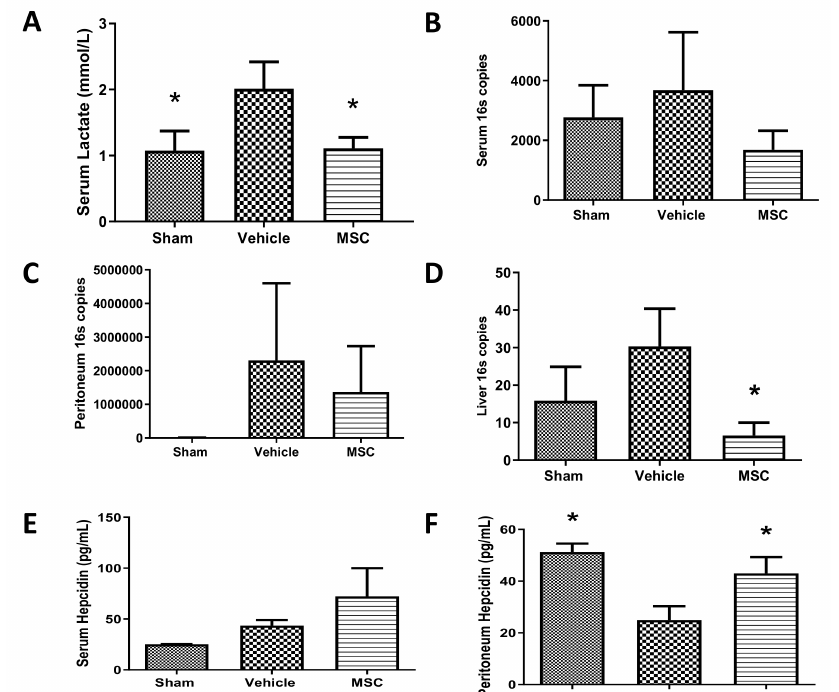
Figure 3. Reduced serum lactate and bacterial genome number and increased antimicrobial peptide after CD362 + UC-MSC administration at 4 h. Administration of CD362 + UC-MSCs 4 h after CLP induction reduced the lactate measured in serum 48 h after the CLP procedure compared with vehicle ( A ). Reduction of copies of the 16S fraction of the bacterial genome in serum after CD362 + UC-MSC administration. ( B ). Reduction of copies of 16S fraction of bacterial genome in peritoneal lavage serum after CD362 + UC-MSC administration ( C ). Reduction of copies of 16S fraction of bacterial genome in the liver after CD362 + UC-MSC administration ( D ). Increased concentration of the antimicrobial peptide hepcidin in serum after CD362 + UC-MSC treatment compared with vehicle control ( E ). Increased presence of the antimicrobial peptide hepcidin in peritoneal lavage in the CD362 + UC-MSC treated group compared with vehicle control ( F ). Bars represent mean ( n = 3 / 8 / 8), error bars represent SD. * Statistically significant ( p < 0.05) with respect to vehicle